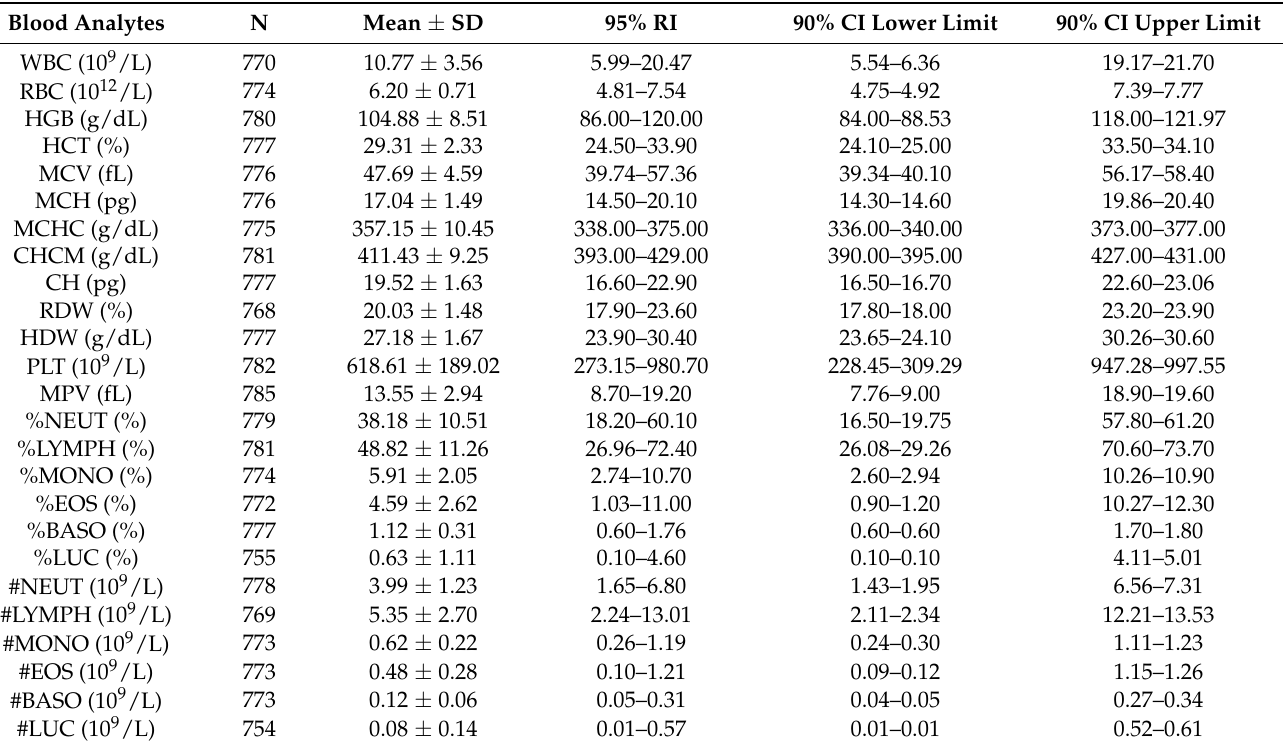
Table 1. Hematology values and RIs for Holstein